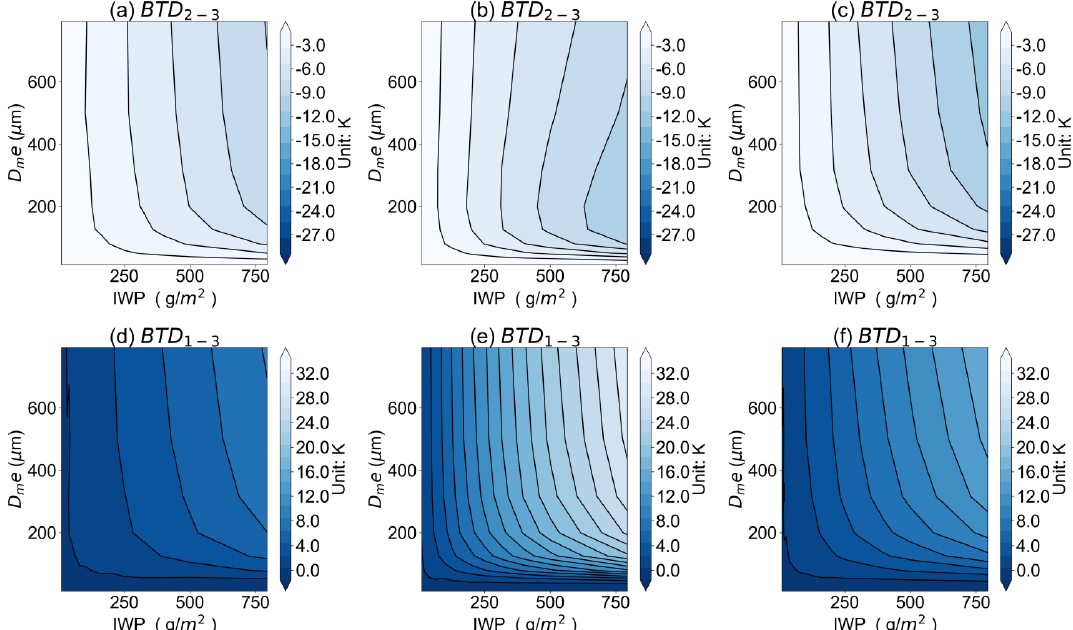
Figure 7. The BTD 2–3 and BTD 1–3 for the (a, d) Voronoi, (b, e) sphere, and (c, f) column ICS models as functions of the IWP and D me , respectively.